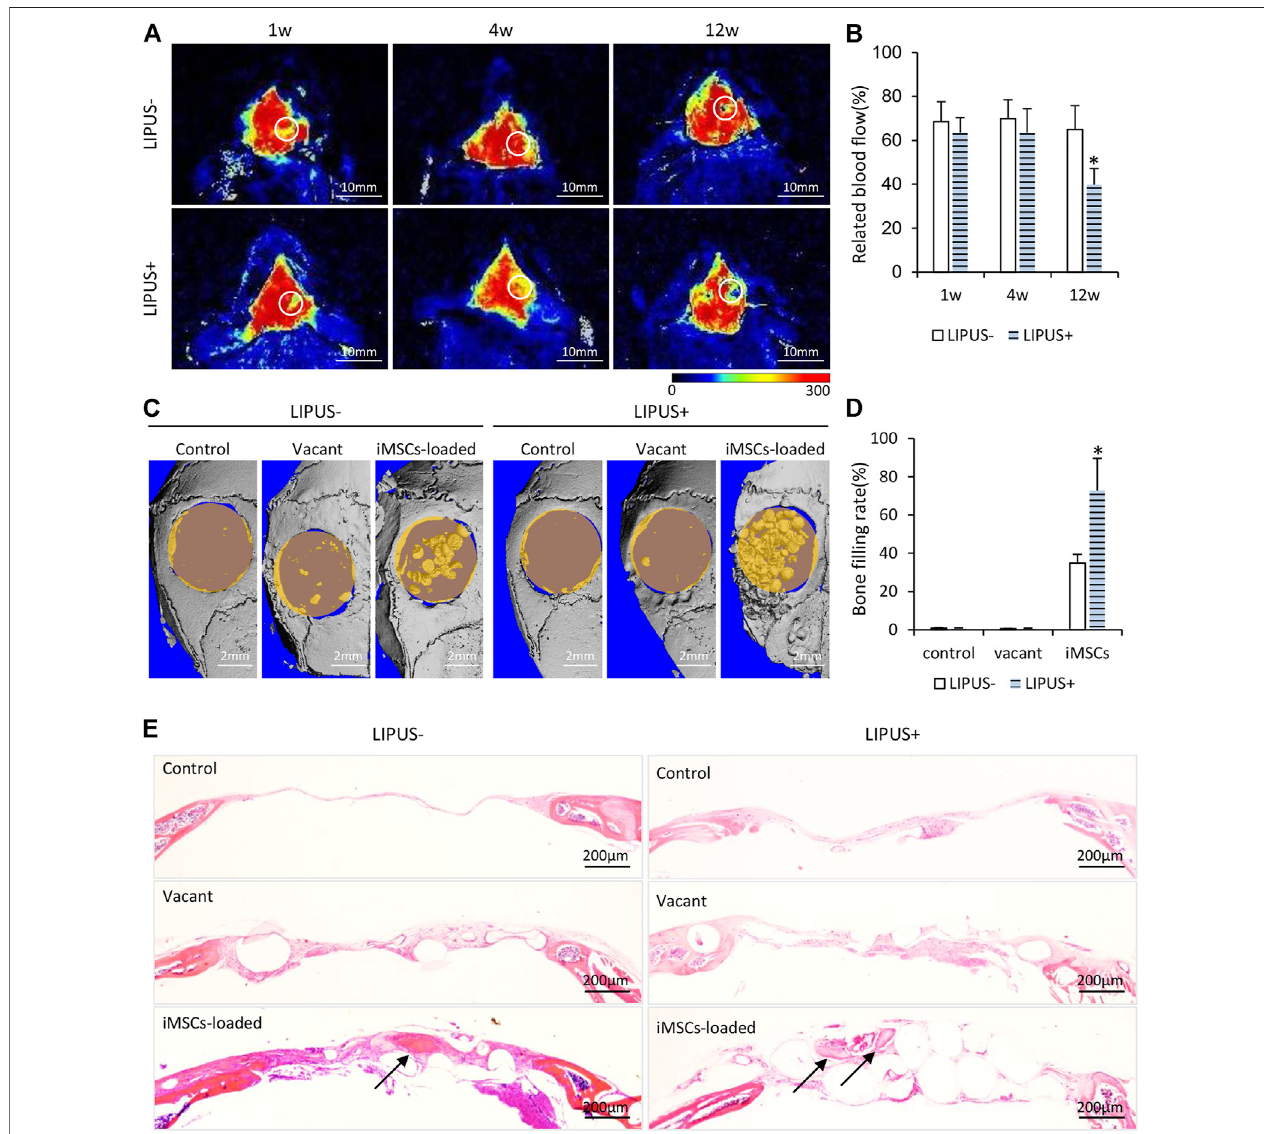
FIGURE 3 | Osteogenic potential of iMSCs under the stimulation of LIPUS40/50 in vivo . (A) Infrared laser speckle imaging of the bone defect implanted of iMSC- loadedmicrobeadswith/withoutLIPUS40/50at1,4,and12 weeks.Thecolorscaleshowedtheblood fl owfrom0(darkblue)to300 mlmin − 1. 100 g − 1 tissue(red).ROIs weredeterminedbythecontourofthebonedefect. (B) Blood fl owquanti fi cationat1,4,and12 weeks; n =5. (C) Micro-CTreconstructionofbonedefectimplantedwith empty microbeads or iMSC-loaded microbeads. Bone defect without implants as control. (D) Bone fi lling rate was evaluated by micro-CT reconstruction. (E) HE staining images at 12 weeks after surgery. Arrows indicate new bone